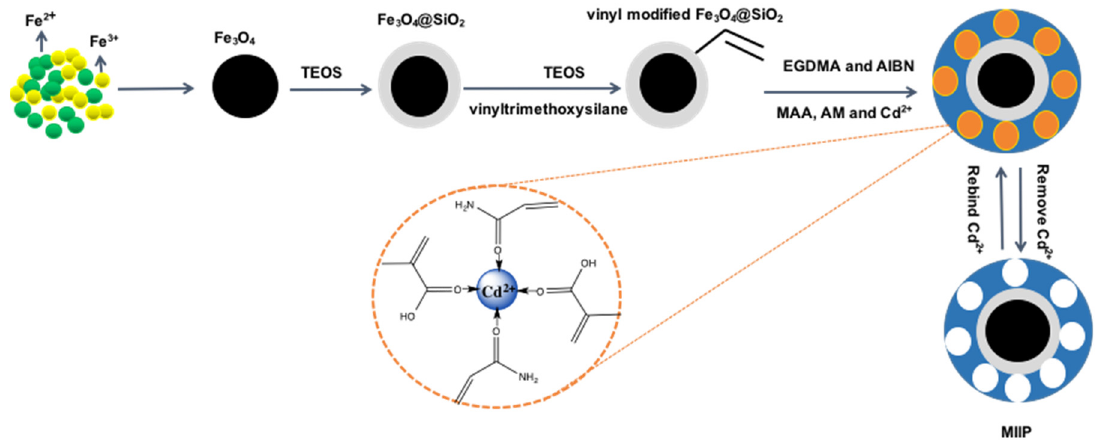
Figure 1. Schematic diagram for the preparation of magnetic ion-imprinted polymer (MIIP).